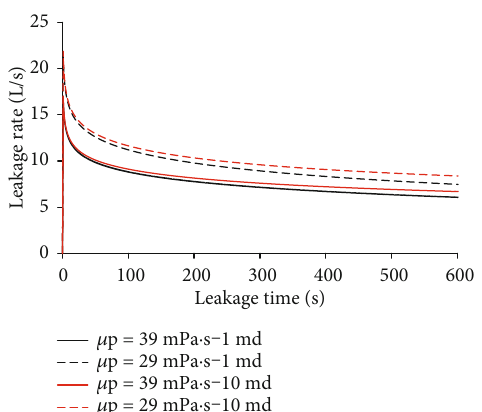
Figure 17: Leakage rate under di ff erent formation permeability and plastic viscosity.